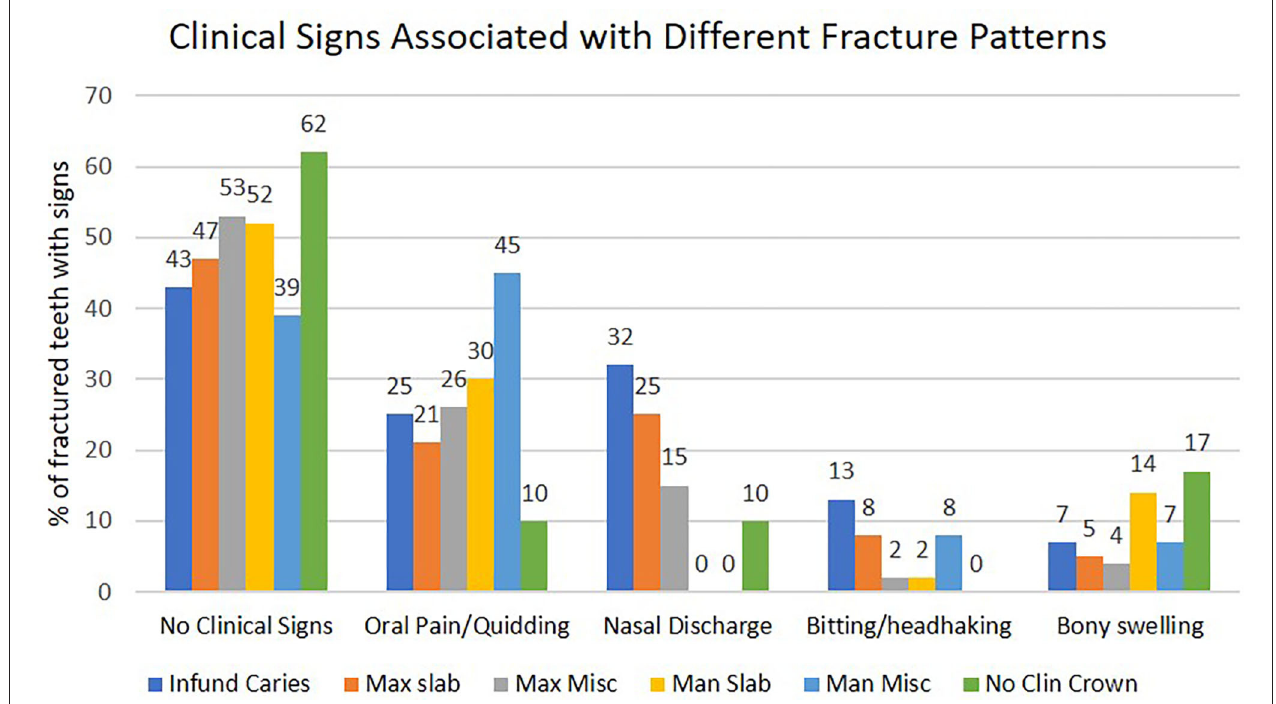
FIGURE 8 | The presenting clinical signs in 300 horses with 486 cheek teeth fractures, subdivided into six different fracture patterns. Infund Caries, infundibular caries-related fracture; Max slab, maxillary first and second pulp horn fractures; Max Misc, atypical maxillary cheek teeth fracture patterns; No Clin Crown, fracture with the absence of clinical crown; Man Slab, mandibular first and second pulp horn fractures; Man Misc, atypical mandibular cheek teeth fracture